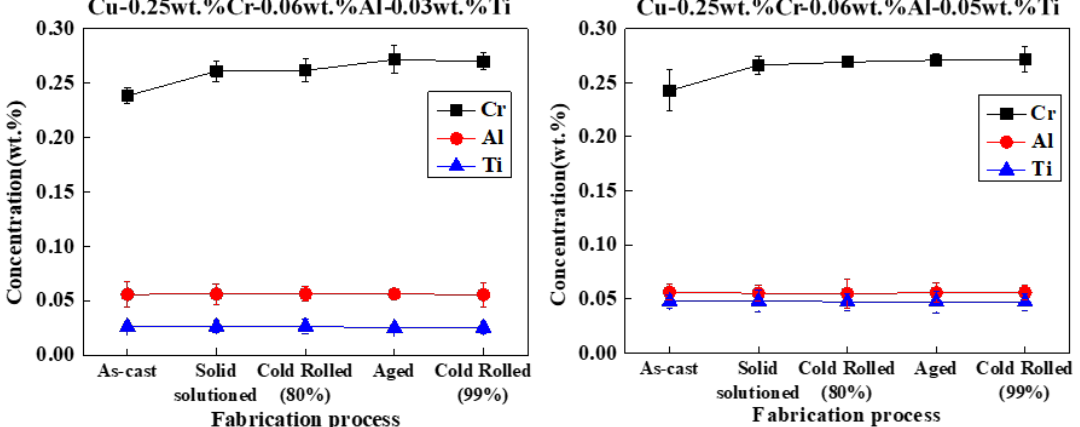
Figure 11. Prediction of solubility and crystallization phase of Cu-Cr alloys by FactSage .®.